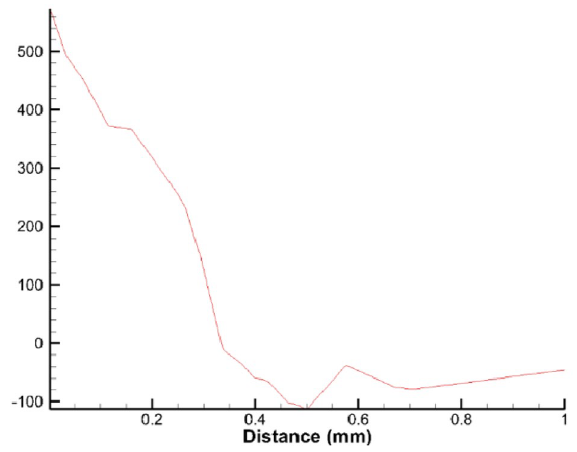
Figure 4. The curve of residual stress with depth distance output by the Third Wave AdvantEdge FEM 7.1.